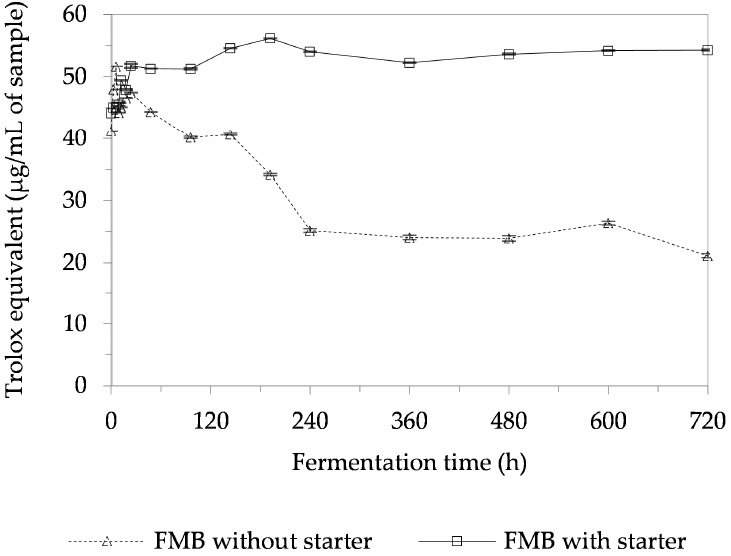
Figure 7. The change of antioxidant activity in a fermented mushroom beverage (FMB) with and without starter culture L. plantarum SK15 during fermentation time.